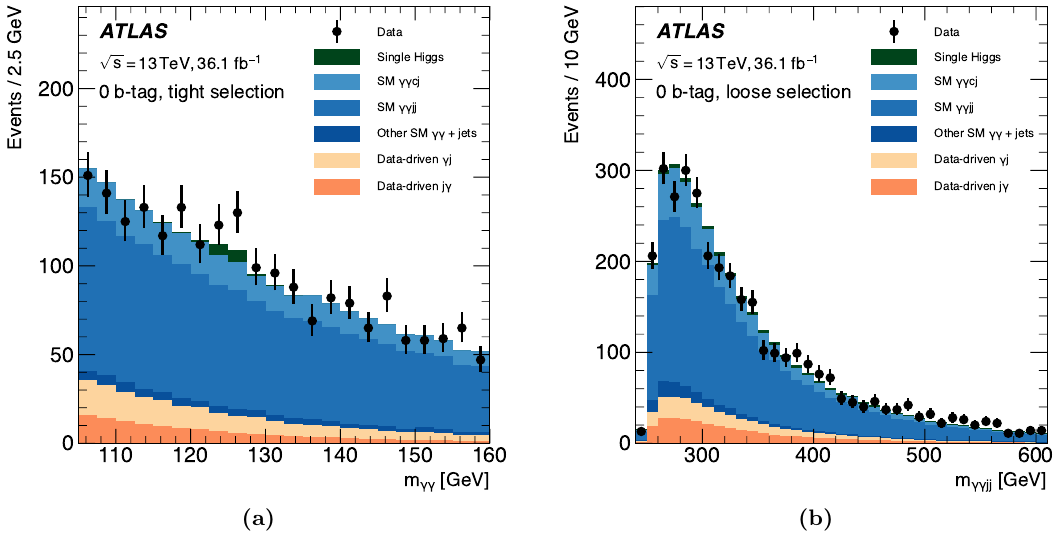
Figure 3. The predicted number of background events from continuum diphoton plus jet produc- tion (blue), other continuum photon and jet production (orange) and single Higgs boson production (green) is compared with the observed data (black points) in the 0-tag control category for (a) the m (cid:13)(cid:13) distribution with the tight selection and (b) the m (cid:13)(cid:13)jj distribution with the loose selection. sideband region 105 GeV < m < 120 GeV and 130 GeV < m < 160 GeV, the total (cid:13)(cid:13) (cid:13)(cid:13) contribution from all backgrounds is equal to that from